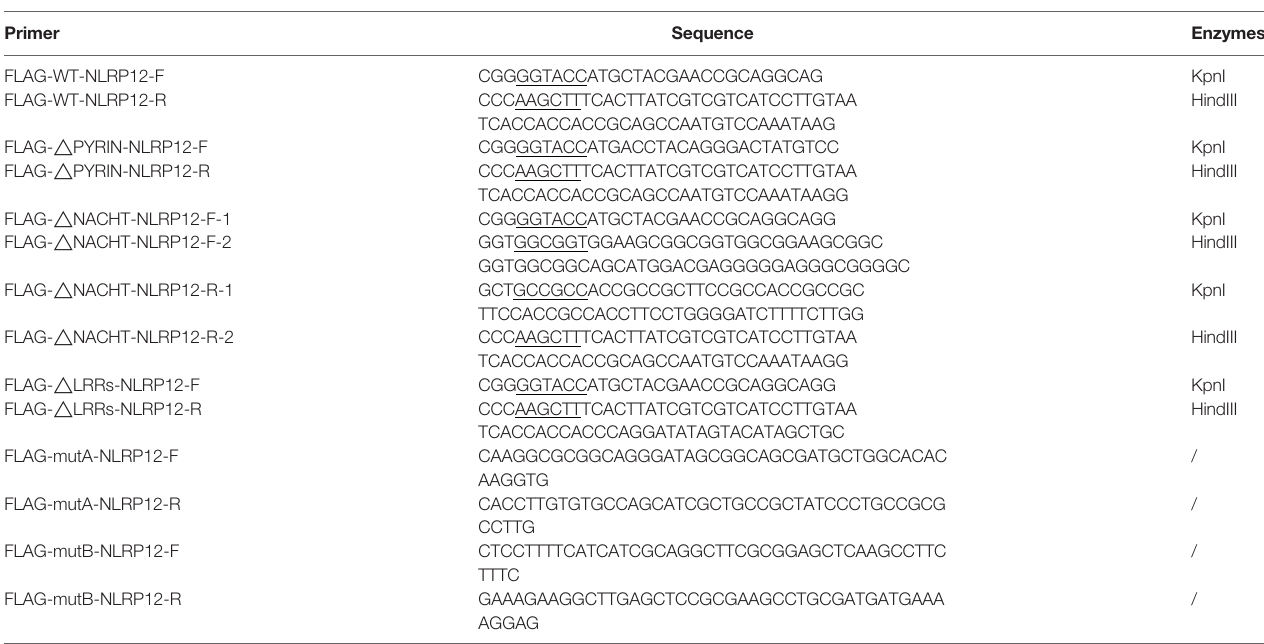
TABLE 2 | Sequences of cloning